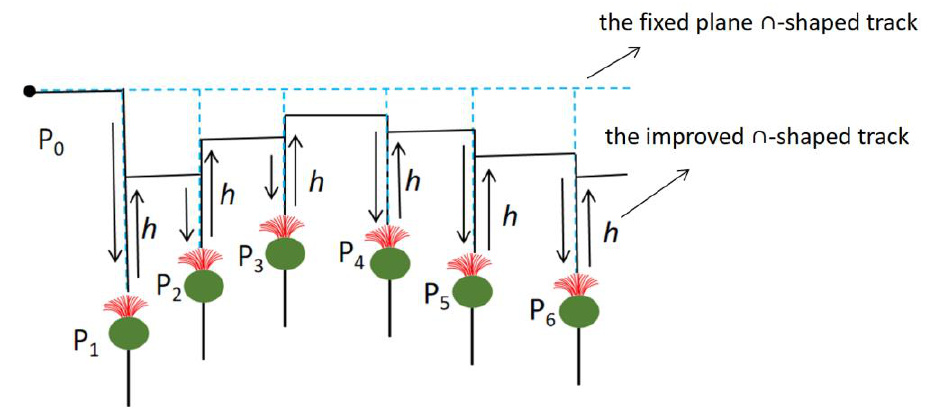
Figure 6. Comparison of two picking track